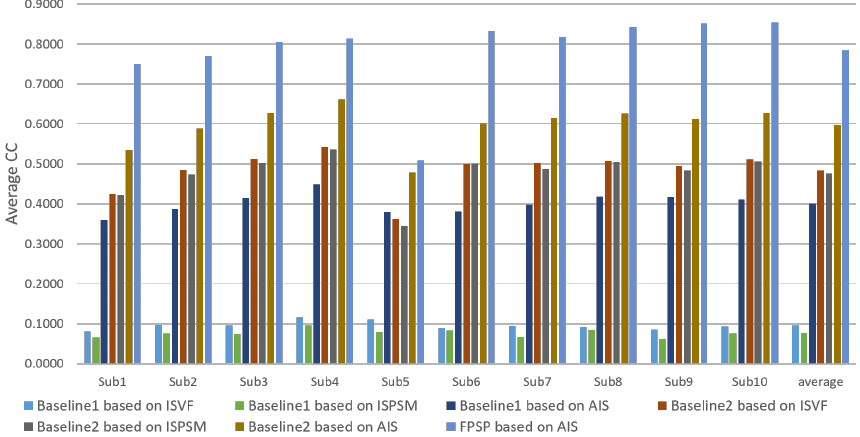
Figure 9. Average CC of each target person ( ↑ ) with comparison to PSM prediction